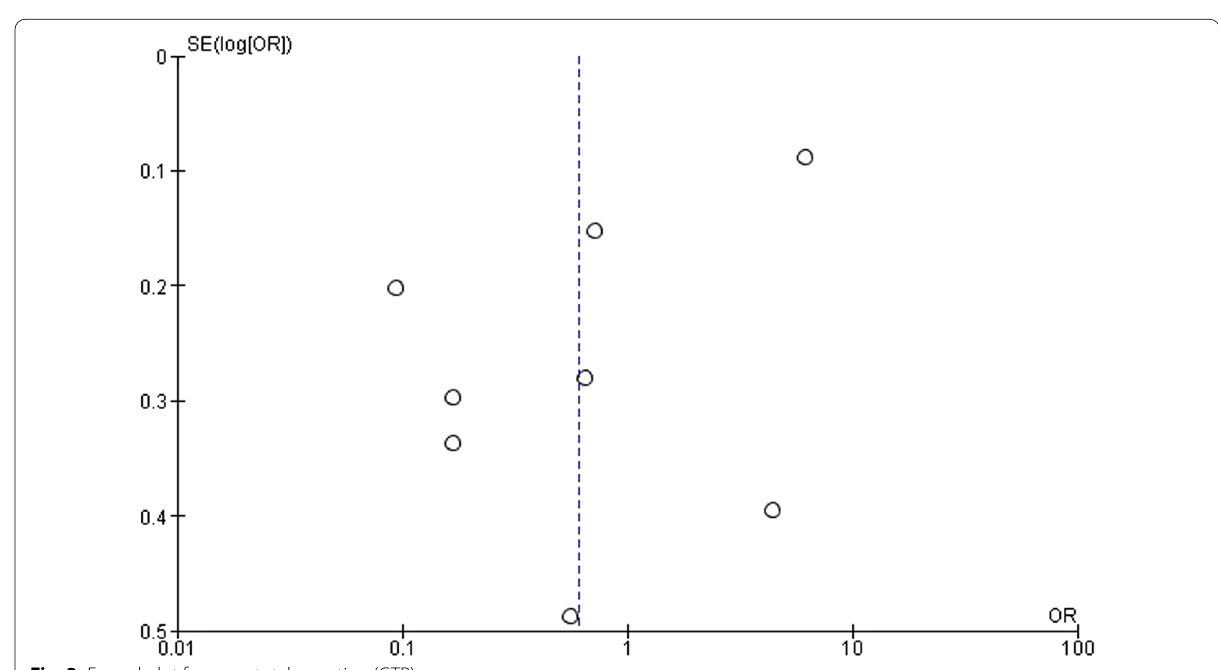
Fig. 3 Funnel plot for gross total resection